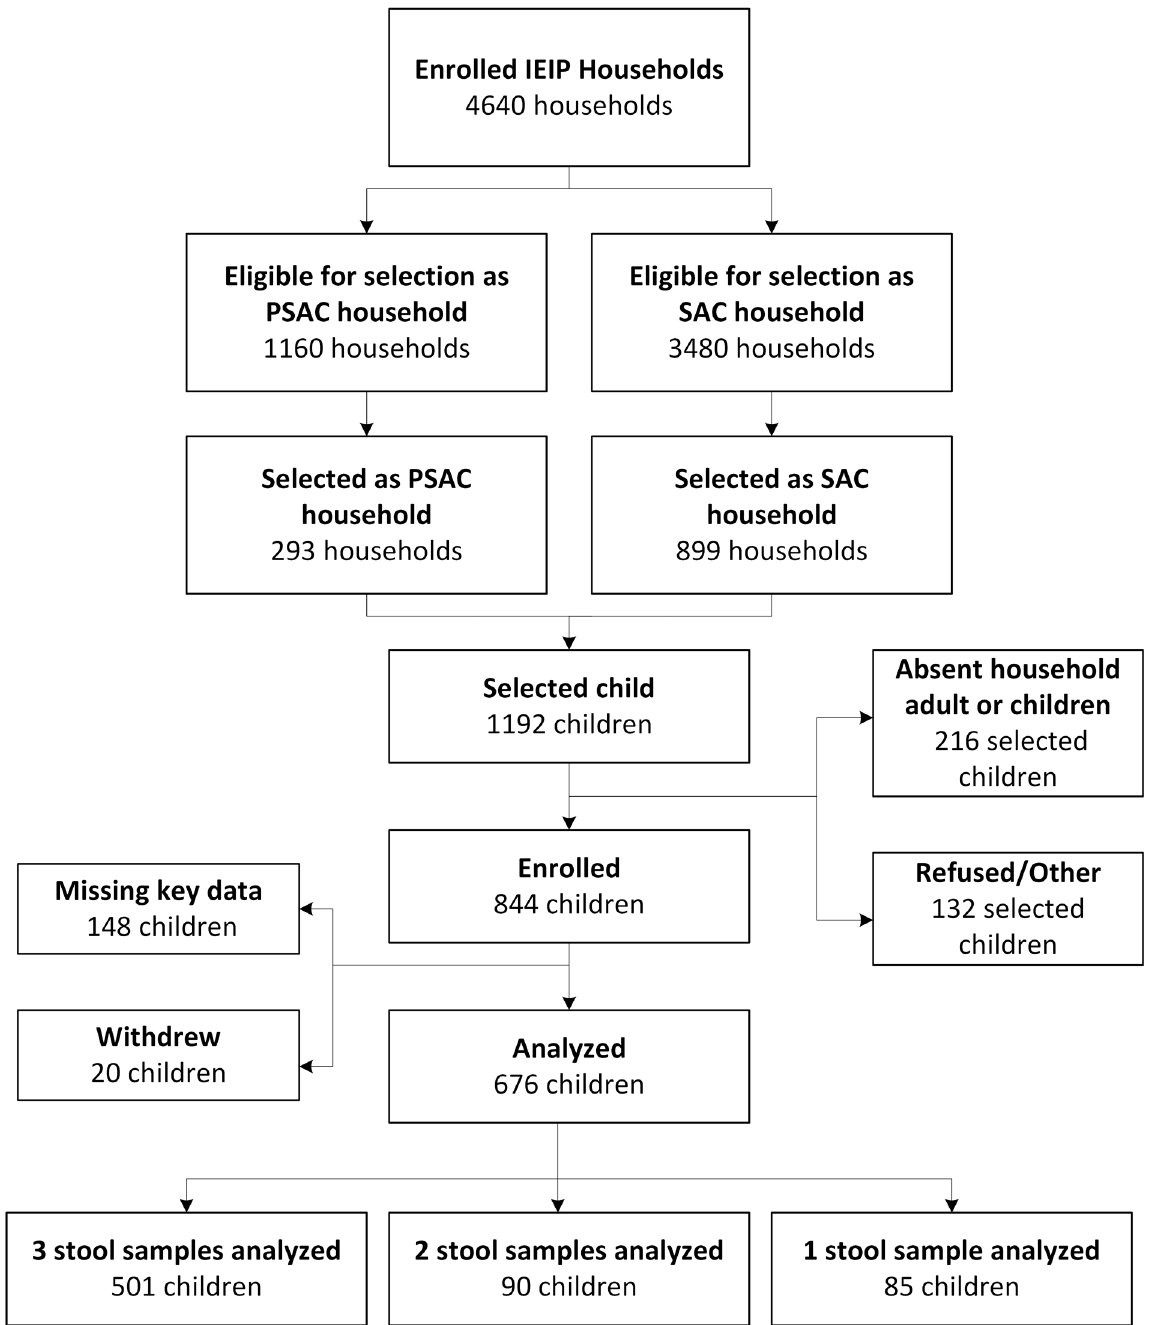
Fig 2. Participant flowchart showing participant selection, inclusion and analysis